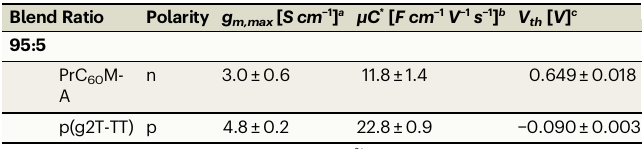
Table 2 | Summary of blend-based OECT characteristics Blend